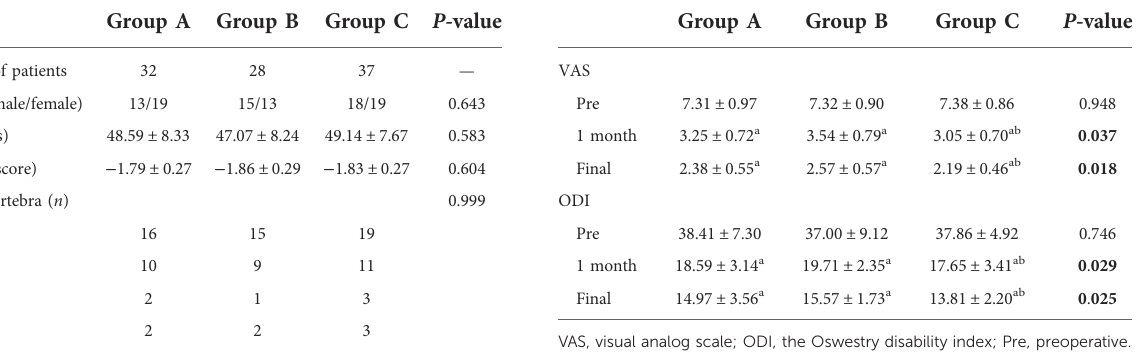
TABLE 3 The functional outcomes of